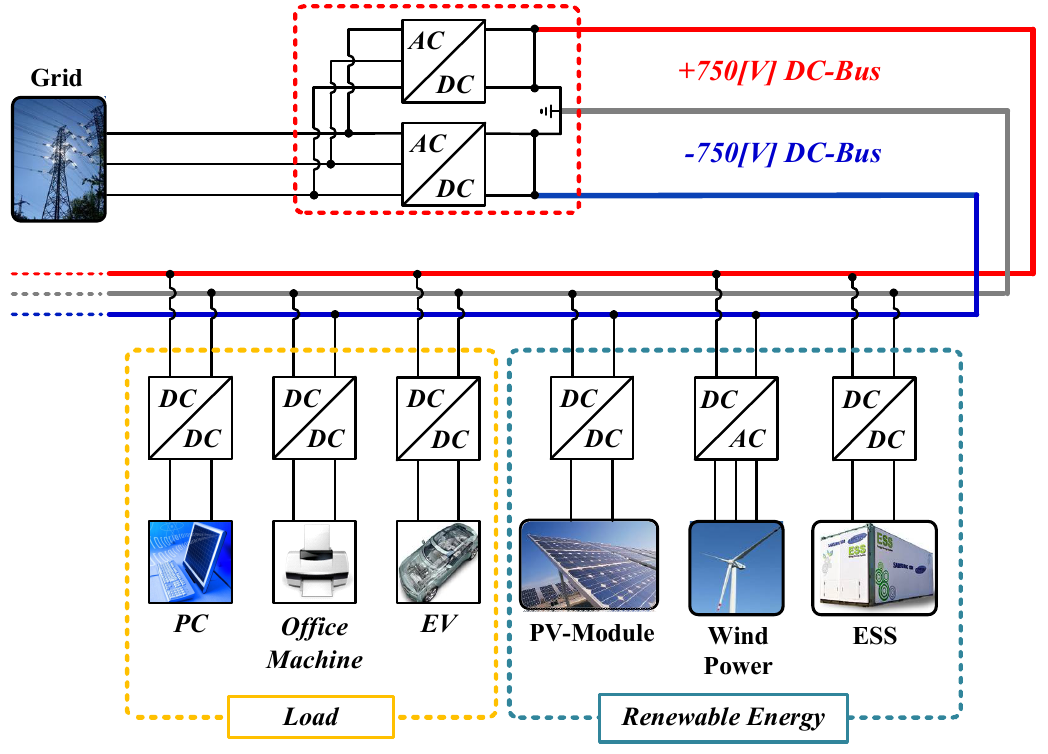
Figure 1. Configuration of DC distribution.